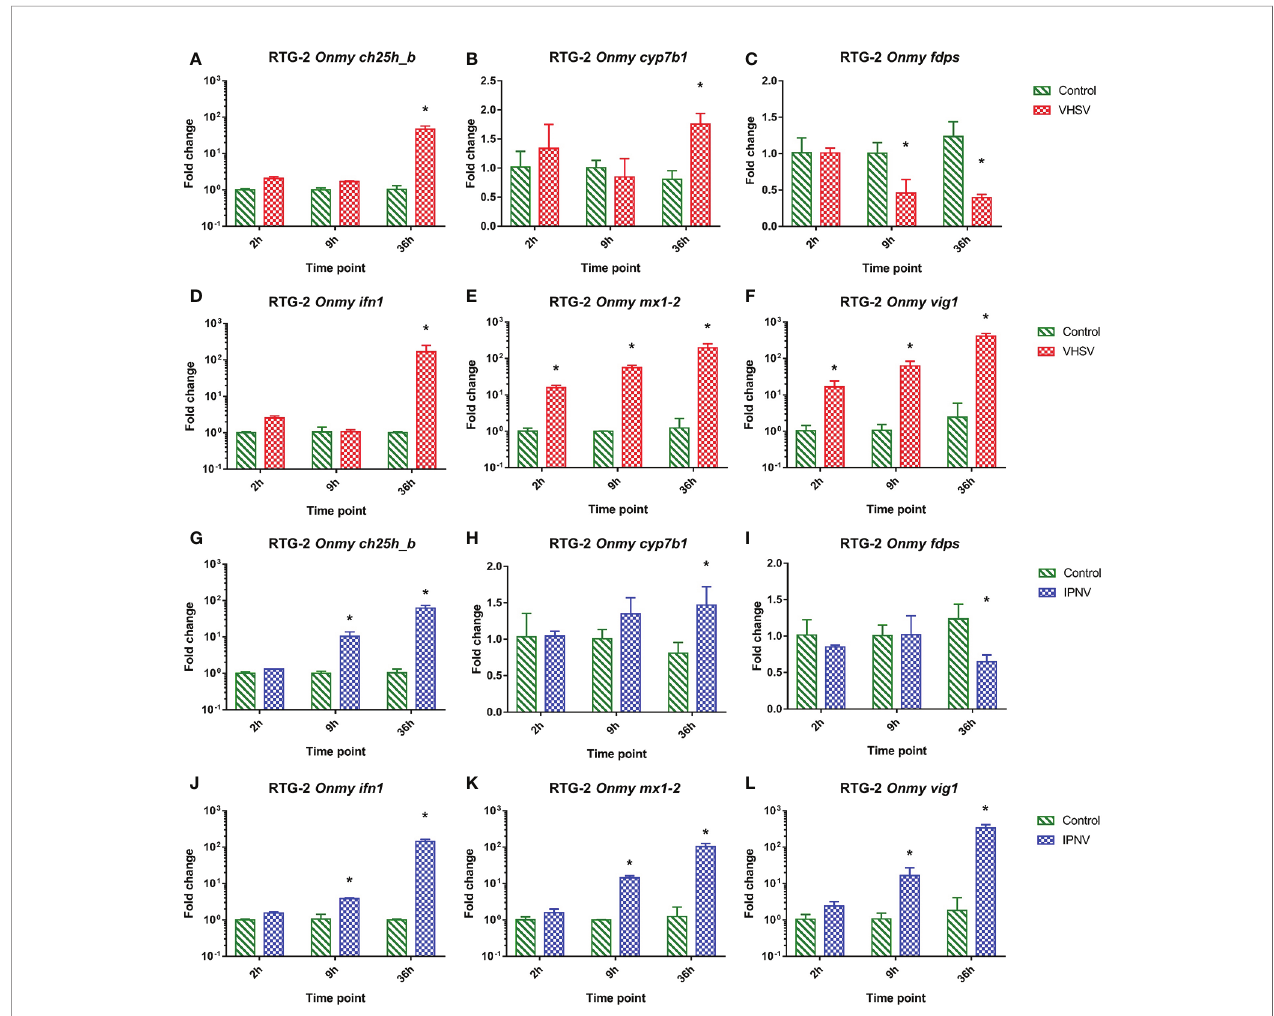
FIGURE 3 | Effect of viral hemorrhagic septicemia virus (VHSV) and infectious pancreatic necrosis virus (IPNV) infection at MOI of 10 on mRNA levels for rainbow trout ( Onmy ) oxysterol generating enzymes ch25h_b (A, G) , cyp7b1 (B, H) , and enzyme in the sterol biosynthesis pathway fdps (C, I) , IFN1 ( ifn a1 ) (D, J) , the IFN1 stimulated genes mx1-2 (E, K) , and vig1 (F, L) . Data presented as a bar indicating mean fold change (+SD) from n = 3 replicates. * indicates a statistically signi fi cant difference at p<0.05 between control and infected cells. Analysis was performed with two-way ANOVA with infections and time points as factors. The ANOVA was followed by subsequent pairwise multiple comparisons using the Holm-Sidak method.